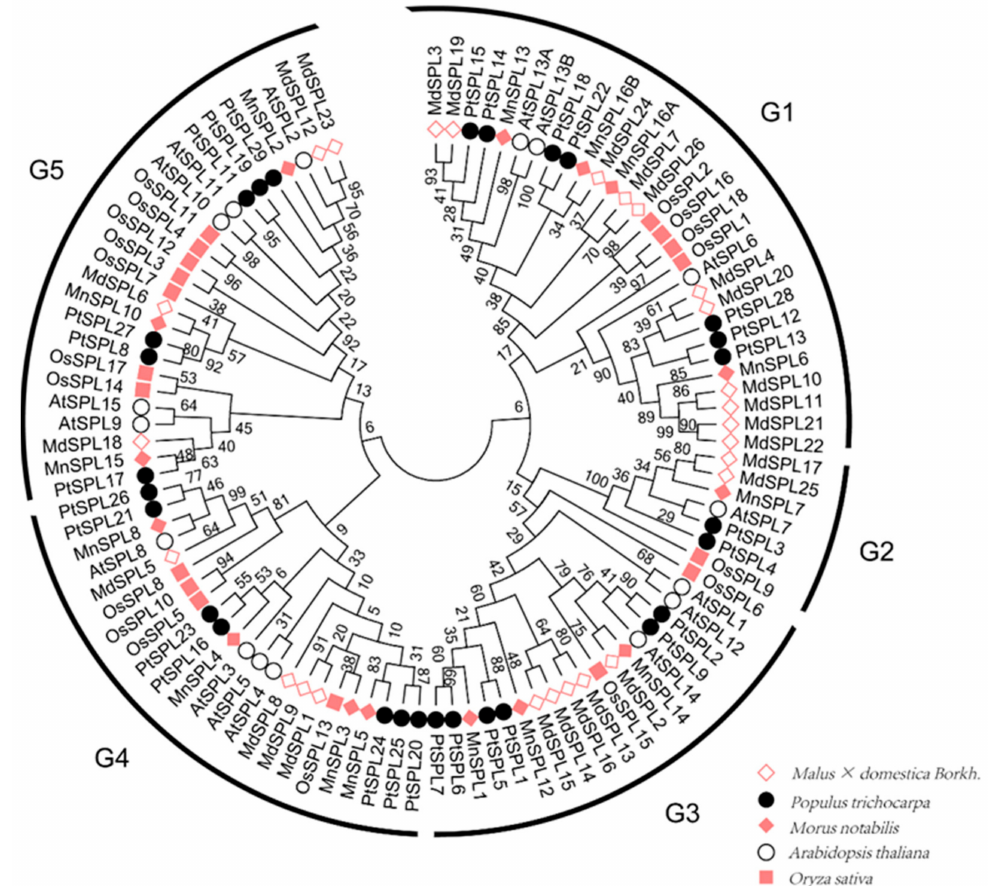
Figure 2. Phylogenetic tree of the SPL family based on the amino acid sequences of SBP domains. Posterior probability values of nodes are shown near the nodes. Different shapes represent different plant species (Md: Malus × domestica Borkh ; Pt: P. trichocarpa ; Mn: M. notabilis ; At: A. thaliana ; Os: O. sativa